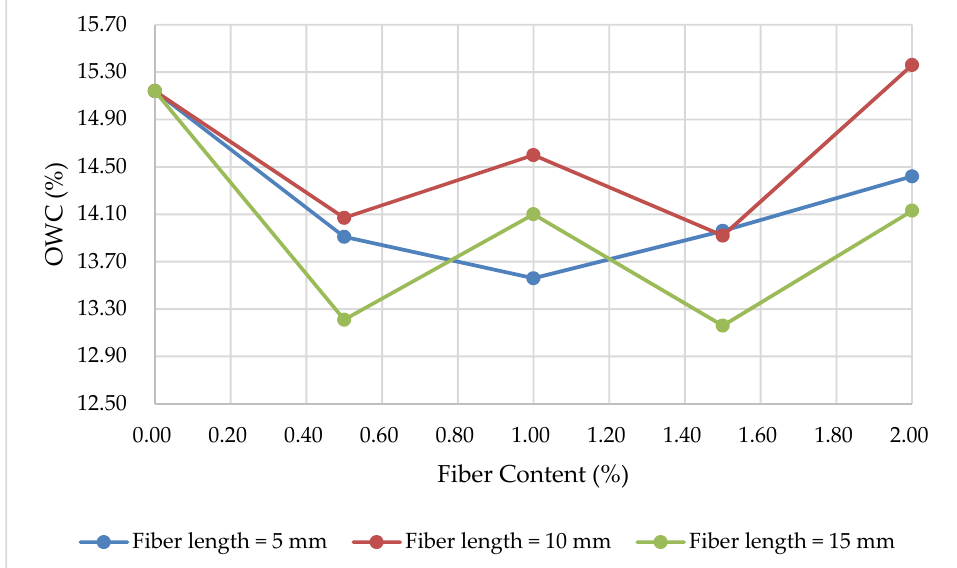
Figure 7. Levels of optimum water contents relative to percentage of fiber content.